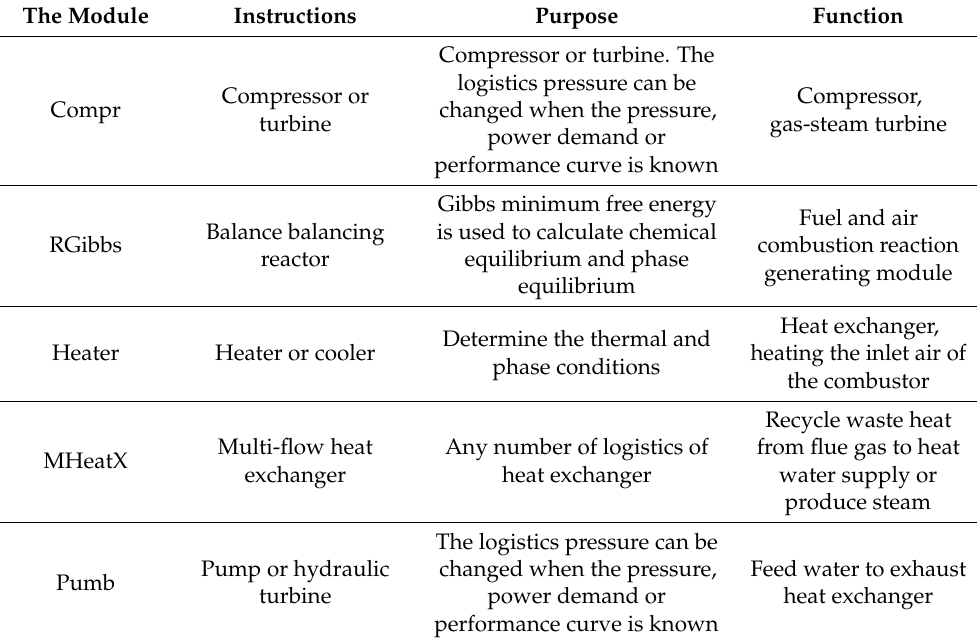
Table 1. An introduction to the modules required to simulate the process.